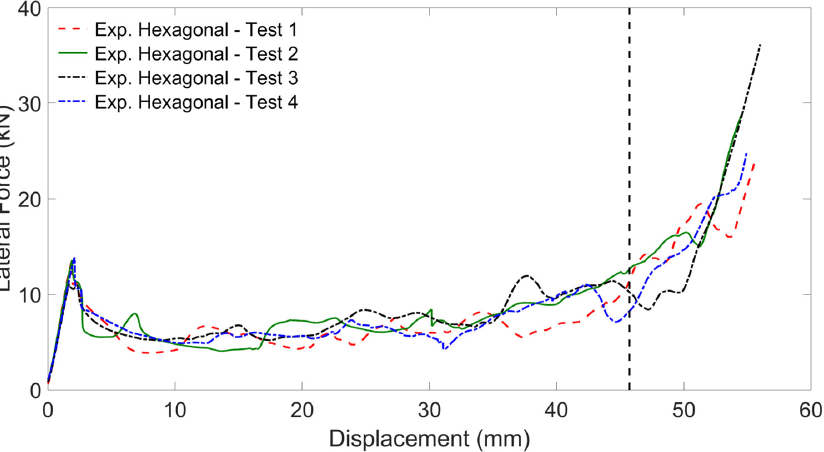
Figure 20. Experimental force ‐ displacement curves of the large ‐ scale specimens constituted by the hexagonal cell geometry and undergoing lateral load.